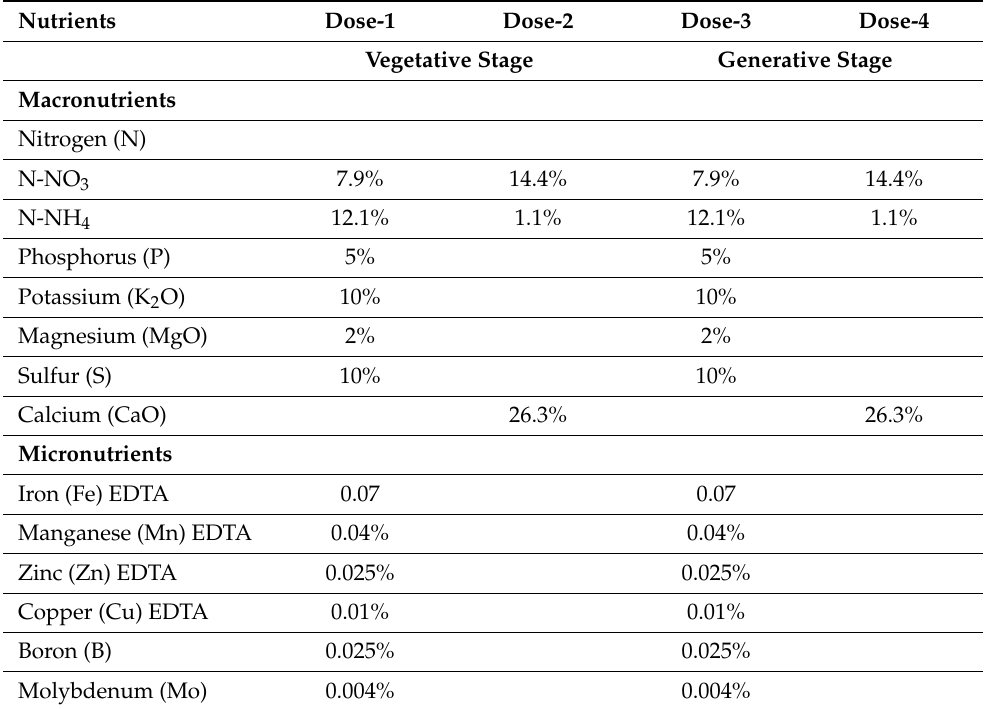
Table 2. A standard stock solution of nutrients at 0.25% ( v / v ) dilution rate, used in different strawberry growing